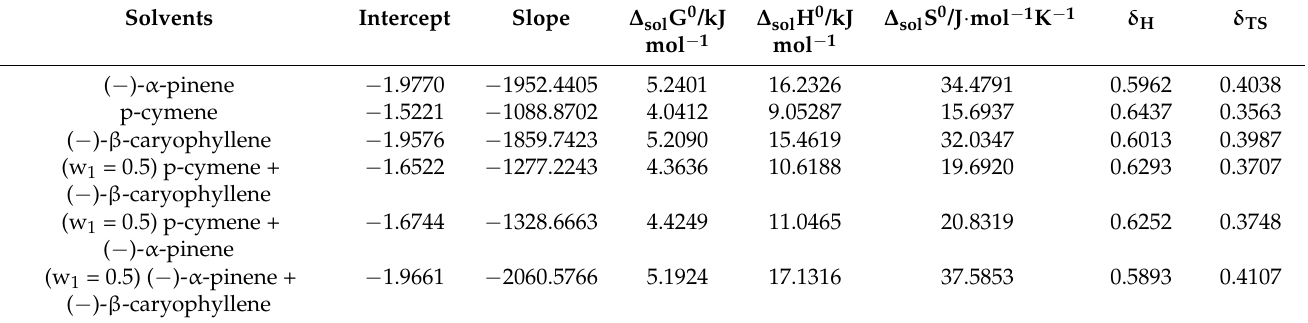
Table 12. Values of apparent thermodynamic properties of solutions ( ∆ sol G 0 , ∆ sol H 0 , ∆ sol S 0 ) of dehydroabietic acid in solvents (P = 101.3 KPa) a